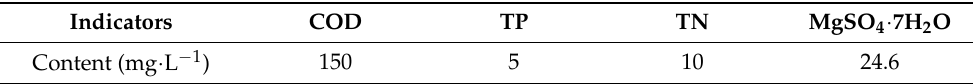
Table 2. Parameters of the inlet wastewater (COD: Chemical Oxygen Demand; TP: Total phosphorus; TN: Total